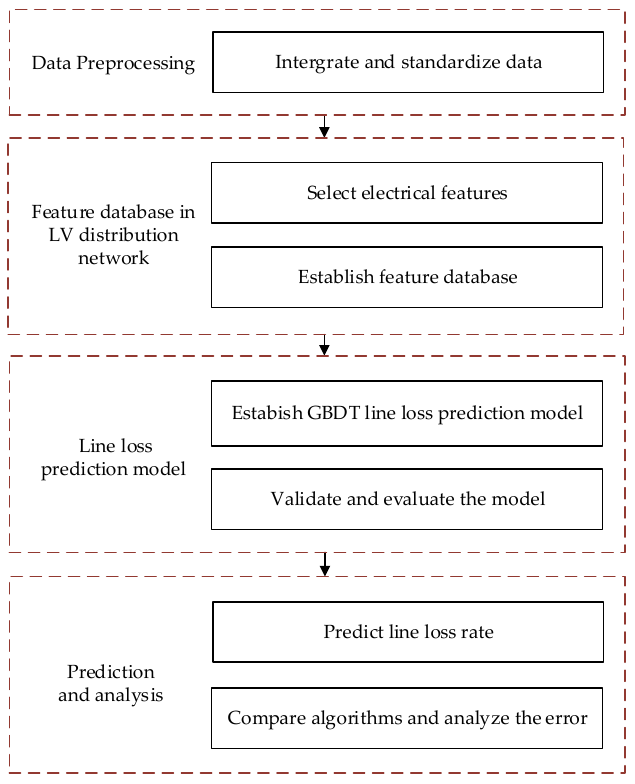
Figure 3. Process of predicting line loss rate based on